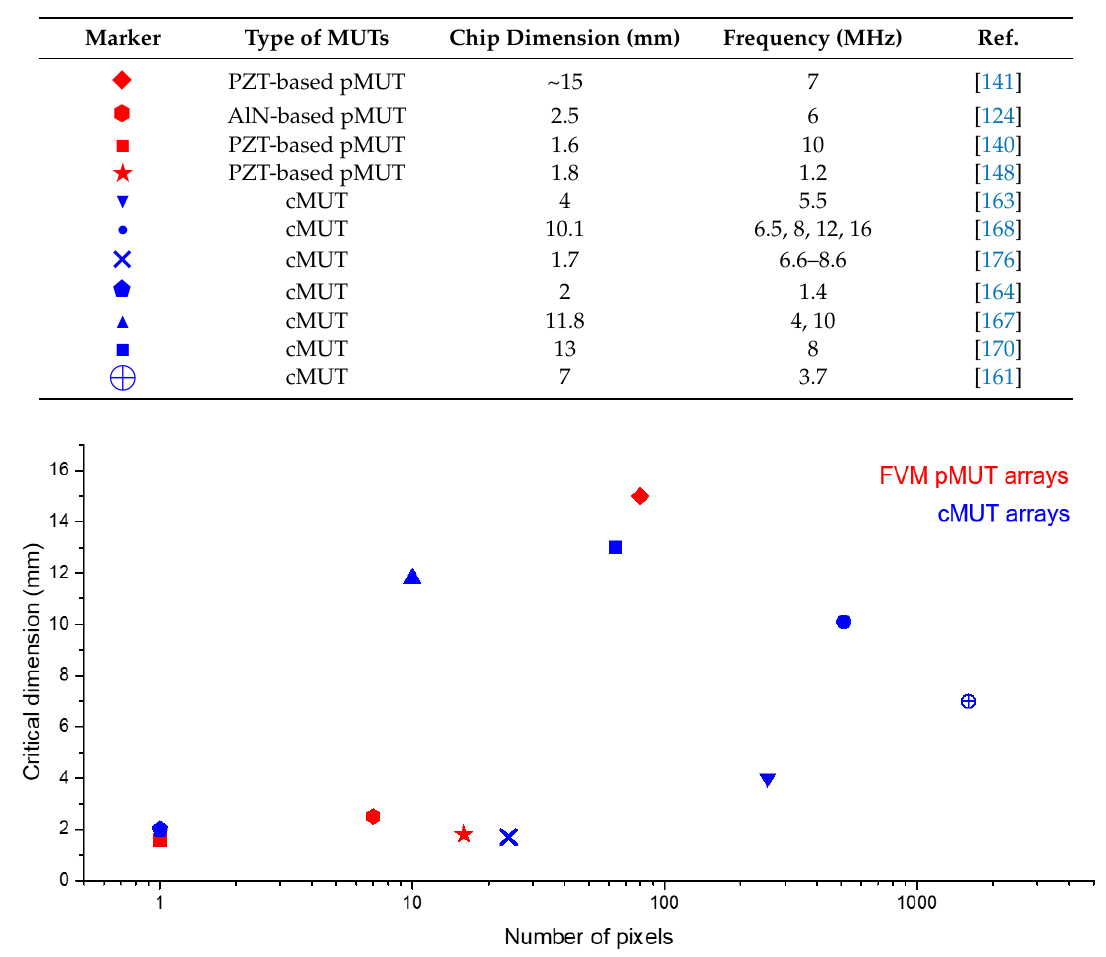
Table 8. Summary of FVM pMUT arrays and cMUT arrays for PAI applications.